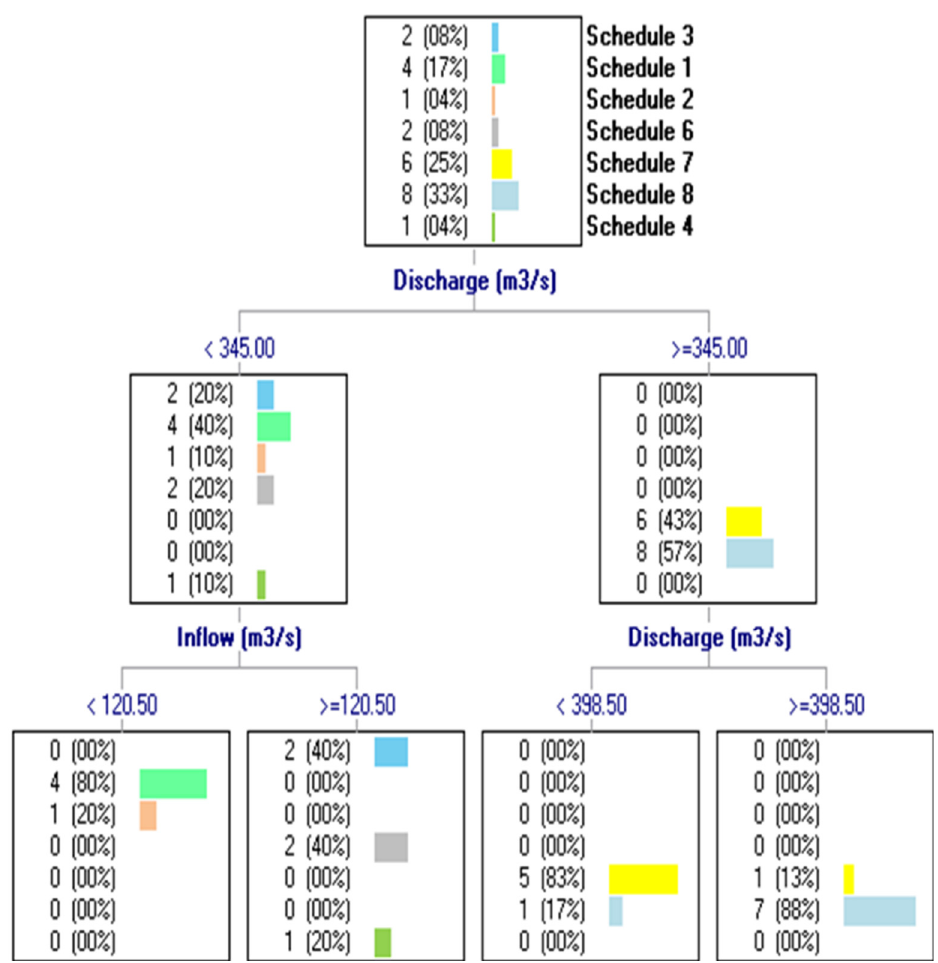
Figure 12. Decision tree by using improved C4.5 Tianshengqiao plant 2 for the winter season.